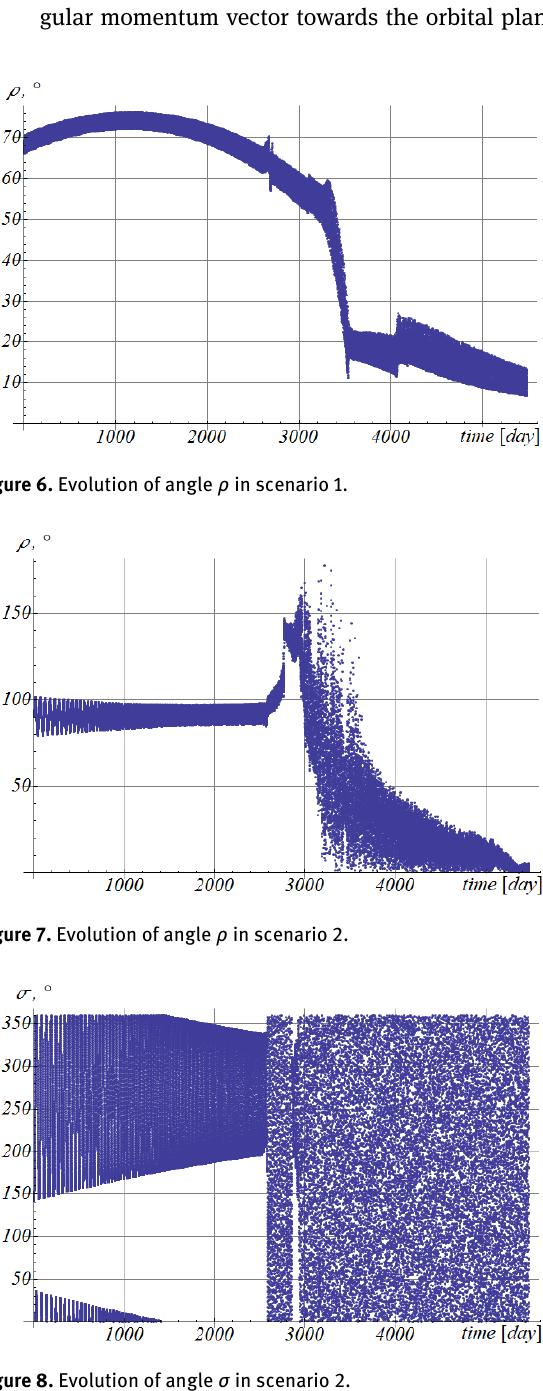
Figure 8. Evolution of angle σ in scenario